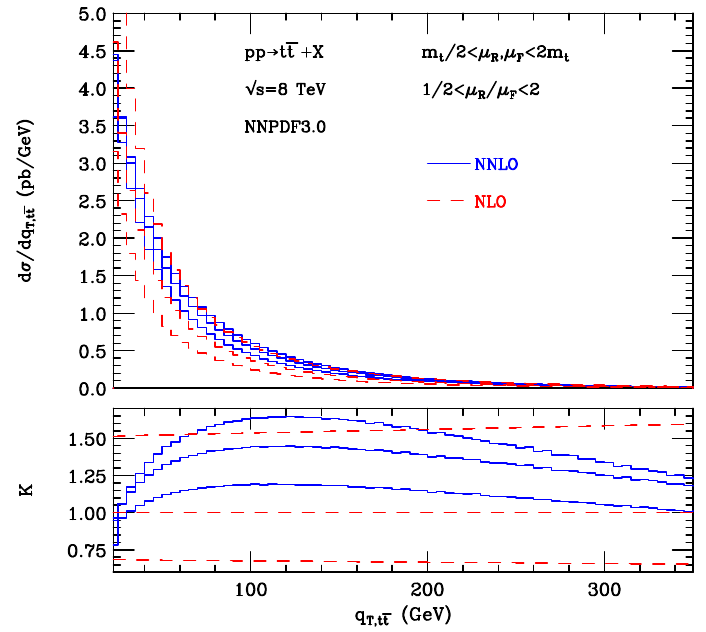
Figure 1. The q T cross section dσ/dq T of the t ¯ t pair produced in pp collisions at √ s = 8 TeV: NLO (red dashed) and NNLO (blue solid) theoretical predictions at central scales and including scale dependence. The lower panel shows the ratio K of the NNLO and NLO results (blue solid), and the relative scale dependence at NLO (red